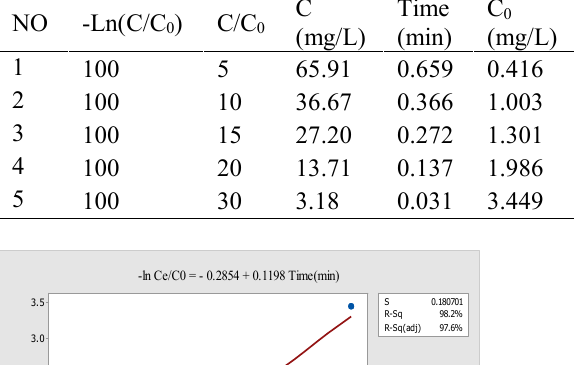
Table 3. Kinetic coefficients of reaction in removal of acid blue 113 dye